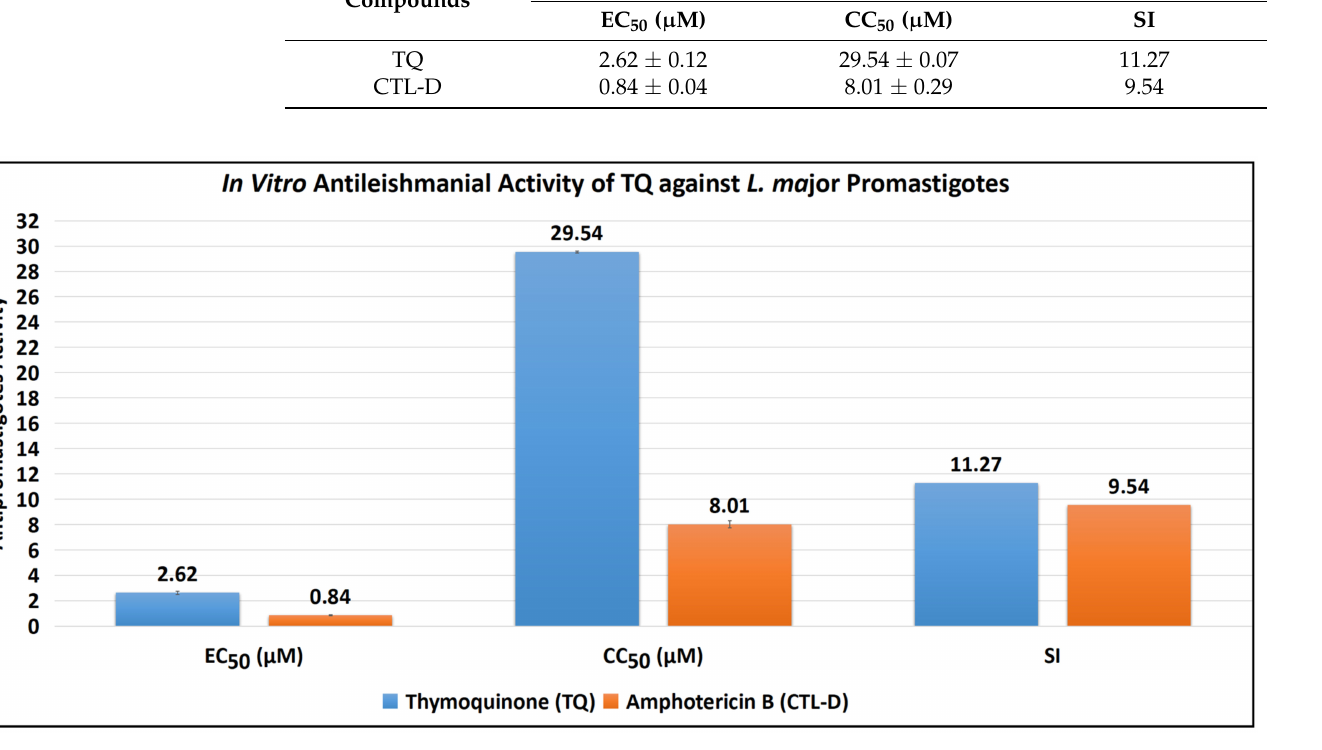
Figure 2. Antipromastigote activity of TQ and CTL-D. Note: All the tests were conducted in triplicate, and the results are presented as mean ± SD.